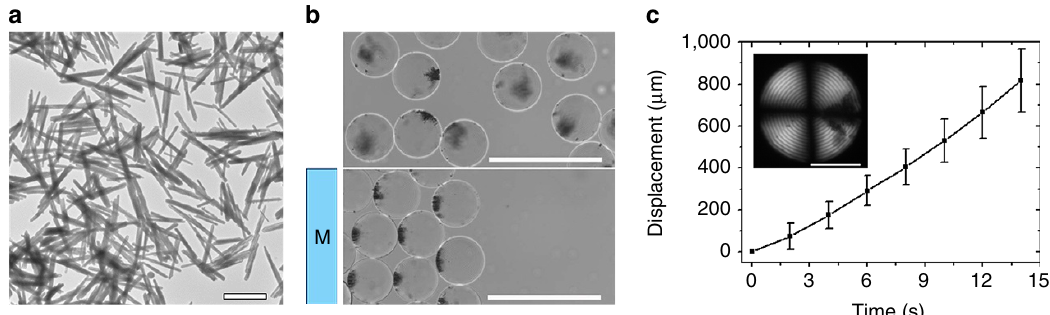
Figure 8 | Magnetic actuation of Ch-CNC droplets loaded with magnetic nanorods. ( a ) TEM images of magnetic Fe 3 O 4 /SiO 2 rods. The scale bar is 1,000nm. ( b ) BF images of Ch-CNC droplets loaded with magnetic nanorods at concentration of 1.5mgml (cid:2) 1 without (top image) and with (bottom image) application of magnetic field. The scale bar is 250 m m. ( c ) Displacement of droplets loaded with Fe 3 O 4 /SiO 2 rods under magnetic field, plotted as a function of time. Inset: POM image of corresponding droplet. The scale bar is 50 m m. The error bars represent the s.d. f 0 ¼ 0.043% in b – c